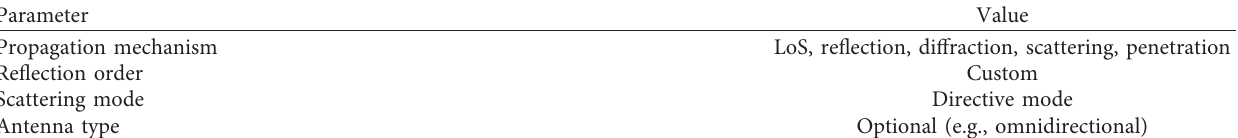
Table 1: Simulation configuration.